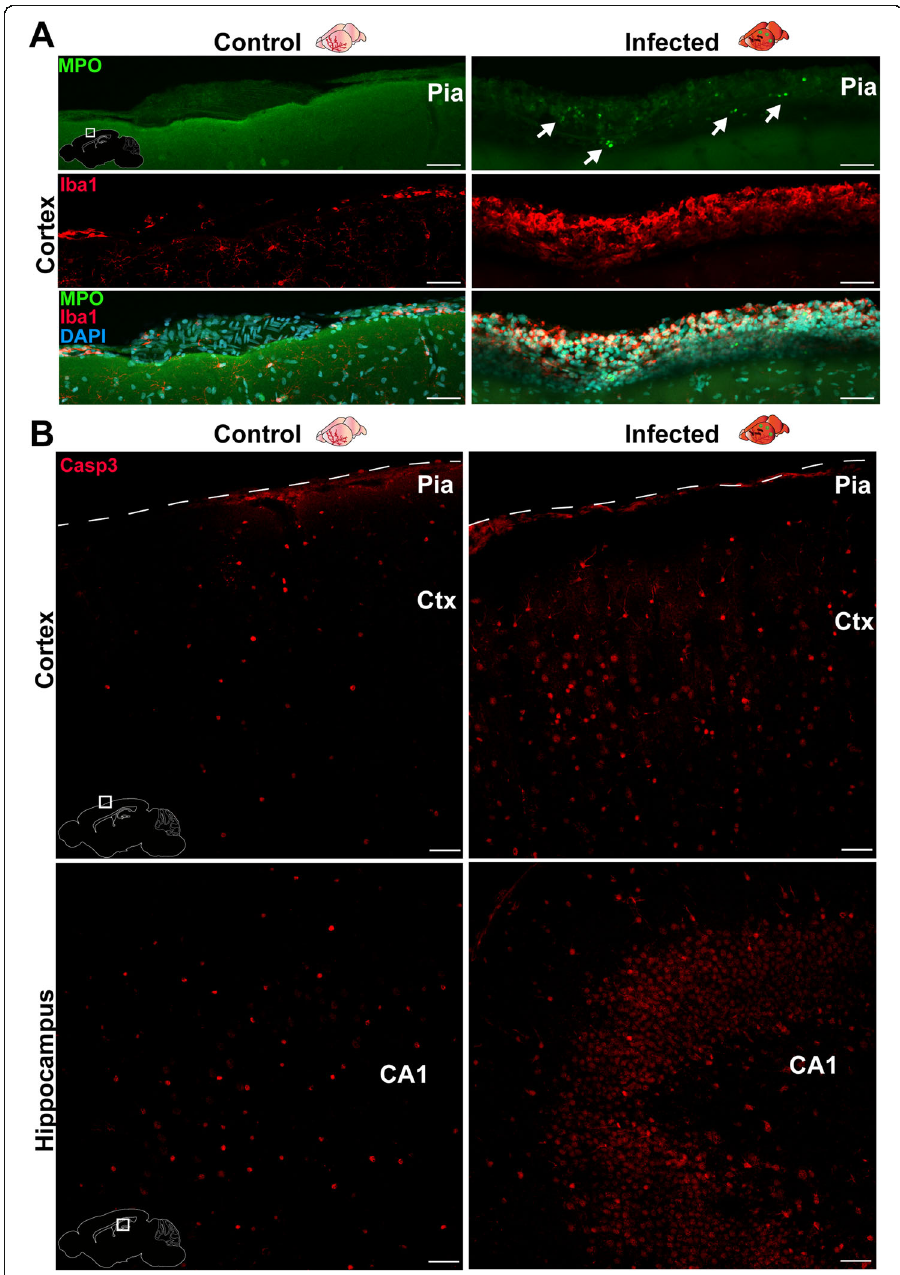
Fig. 2 Brains of infected and control rats. Rats were infected with pneumococci (infected) or with equal volume of saline (control). a Brain sections were stained for neutrophils (MPO, green), macrophages/ microglia (Iba1, red), and DNA (DAPI, blue). An area of the cortex featuring the meningeal space was imaged. White arrows indicate MPO-positive cells (neutrophils). b Brain sections were stained for active Caspase-3, a marker of apoptosis (Casp3, red). An area of the cortex (Ctx, top; dashed line indicates the pia membrane) and the hippocampus (CA1, bottom) was imaged. Scale bars (white horizontal lines) are 50 μ m. White schematic insets depict the imaged brain region in each